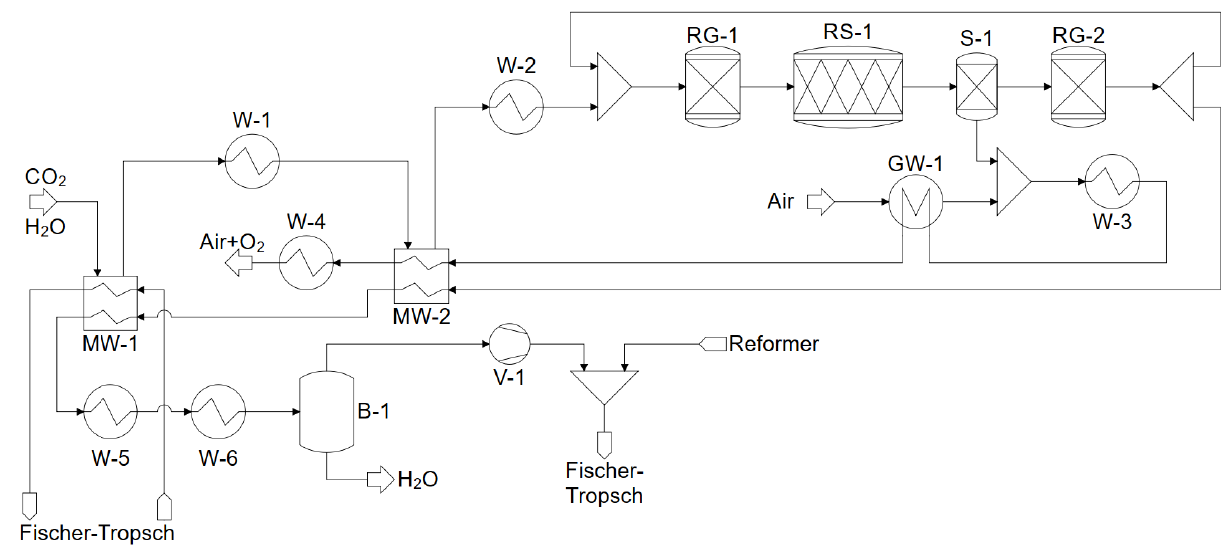
Figure 2. Excerpt from the process flow diagram: co-electrolysis.